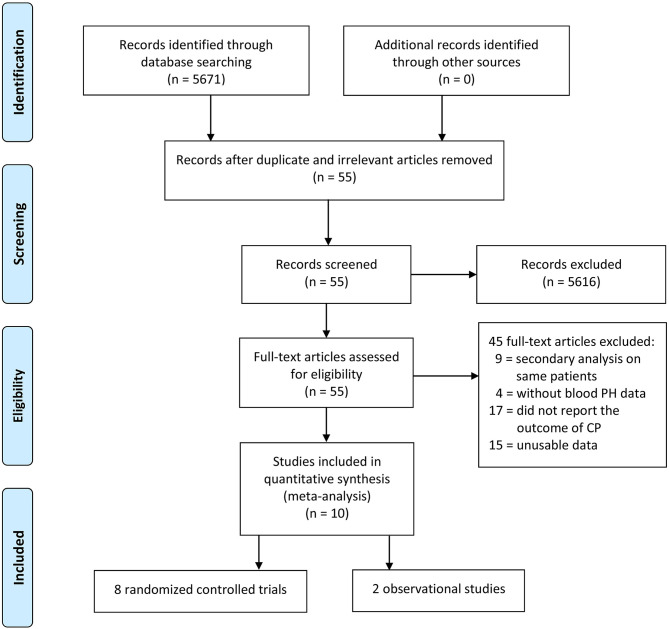
Flow chart for study selection.